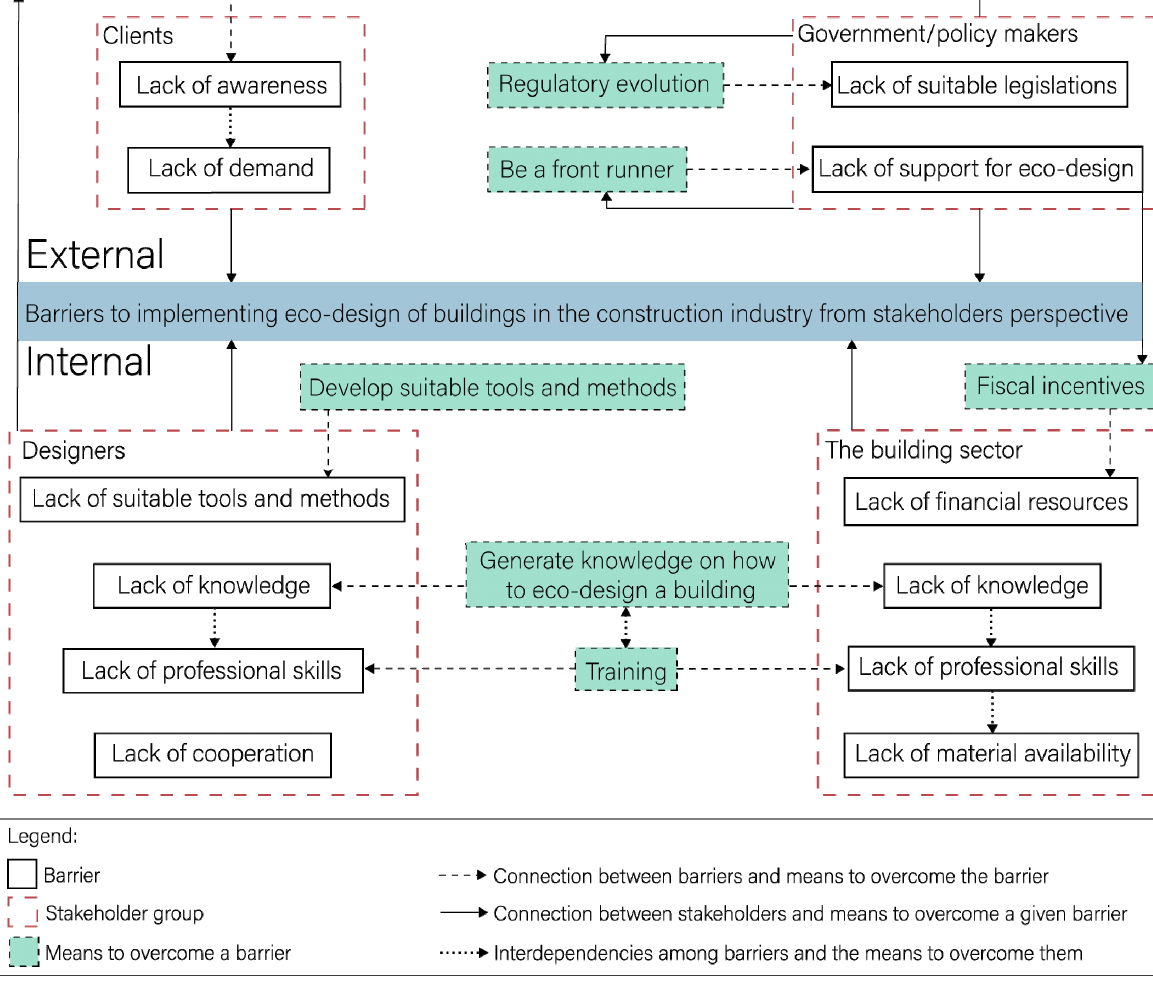
Figure 5. Barriers to implementing eco-design in the building sector connected to the potential means to overcome the barriers.